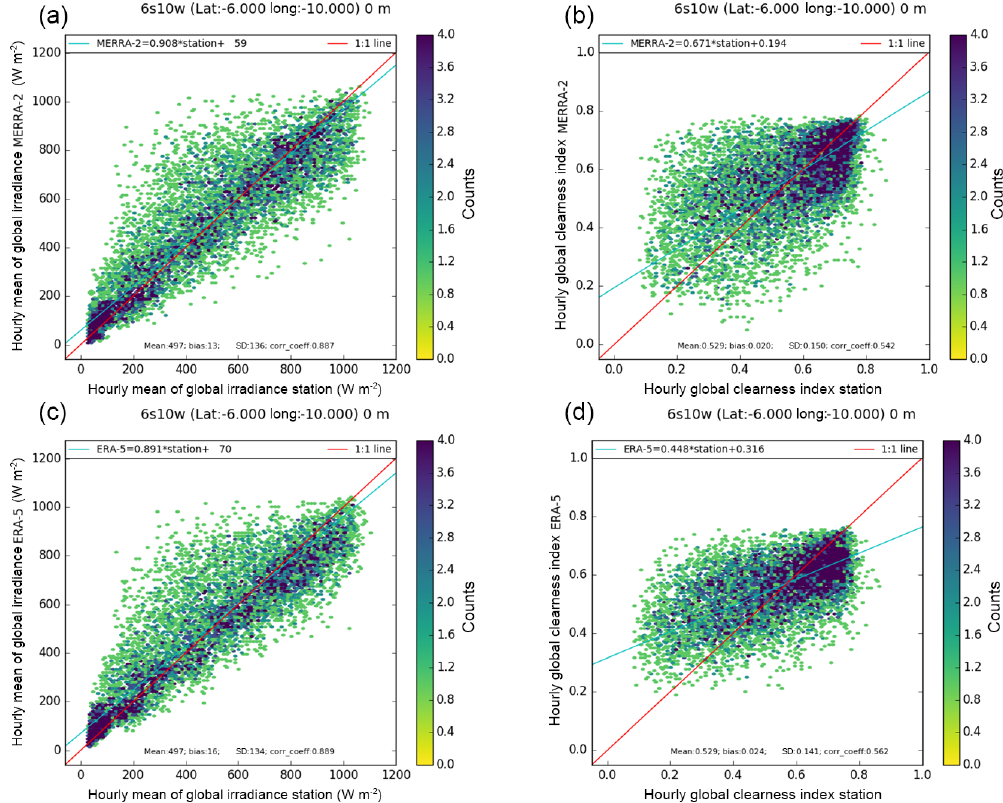
Figure 5. The 2-D histograms of PIRATA measurements (horizontal axis) and data sets (vertical axis) at 6 ◦ S, 10 ◦ W for E and KT. MERRA- 2: (a) and (b) ; ERA5: (c) and (d) . Ideally, the dots should lie along the red line (1:1 line). The blue line is the affine function fitted over the points and should ideally overlay the red